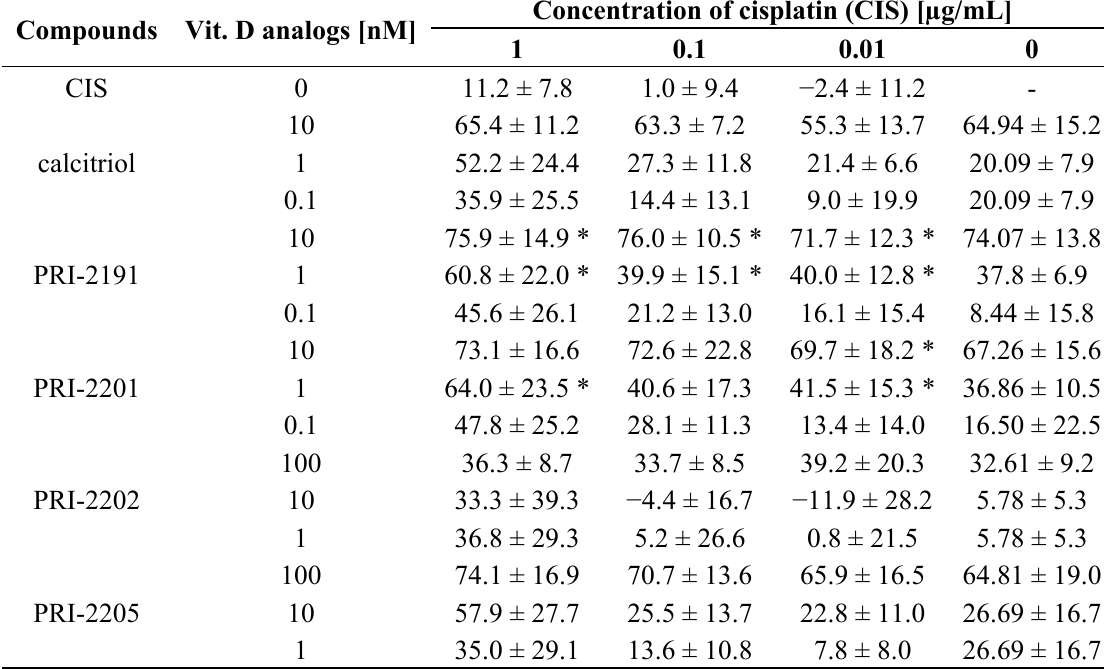
Table 1. Proliferation inhibition of HL-60 cells exposed to calcitriol or its analogs and cisplatin.